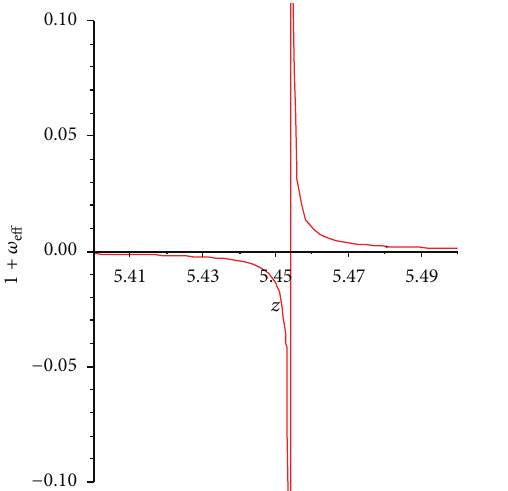
Figure 4: Variation of the deceleration parameter 𝑞 versus 𝑧 for 𝑛 = 0.25 . The transition from deceleration to the acceleration phase occurs at 𝑧 ≈ 2 .